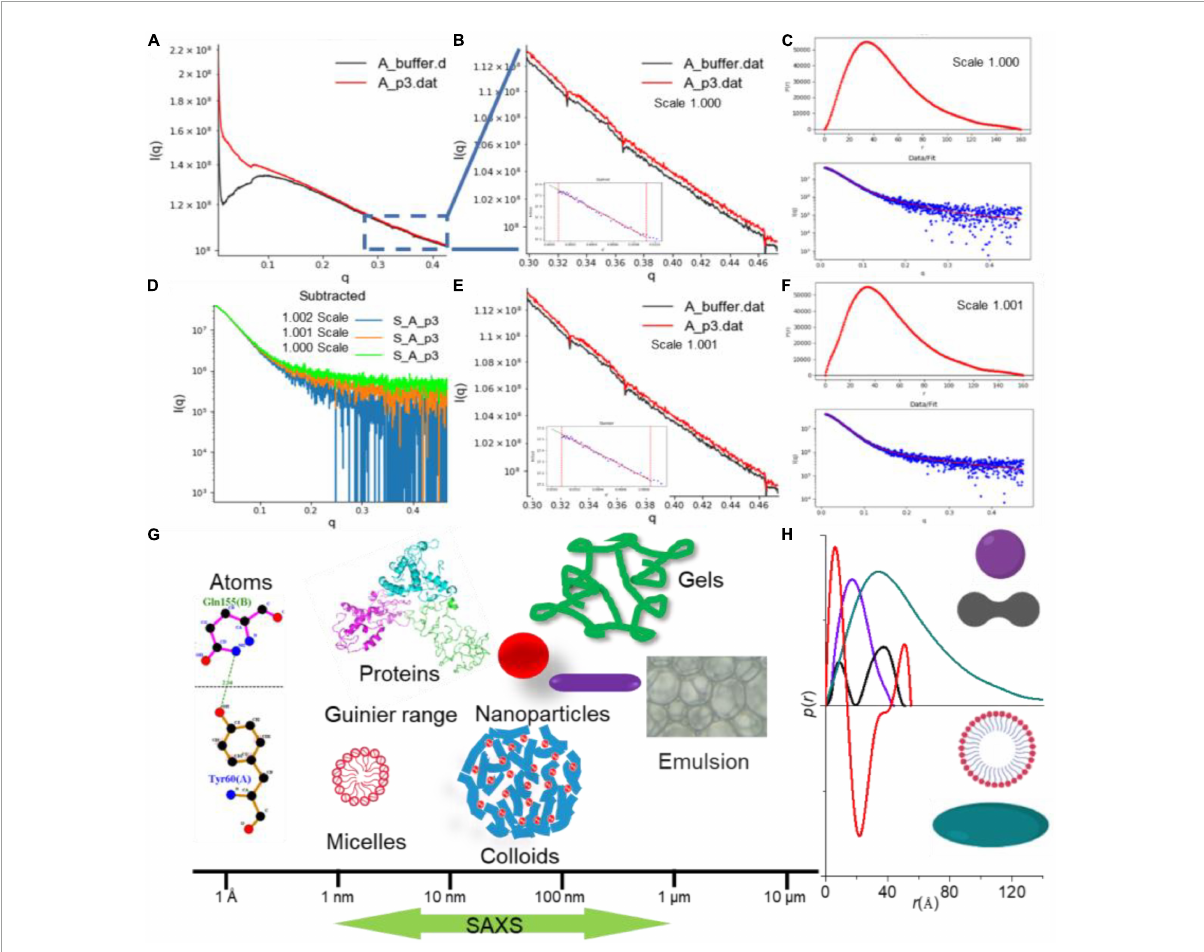
FIGURE2 The small-angle X-ray scattering (SAXS) data analysis by RAW program (22). (A) Background subtraction of caseinate (29). (B–F) Scattering curves showing changes in net scattering intensity in the high q region with different scale factors (1.000 and 1.001), as well as the resulting p ( r ) in different scaling factor. (G) Size determination coverage of SAXS. (H) p ( r ) profile depends on the dimension and shape of the